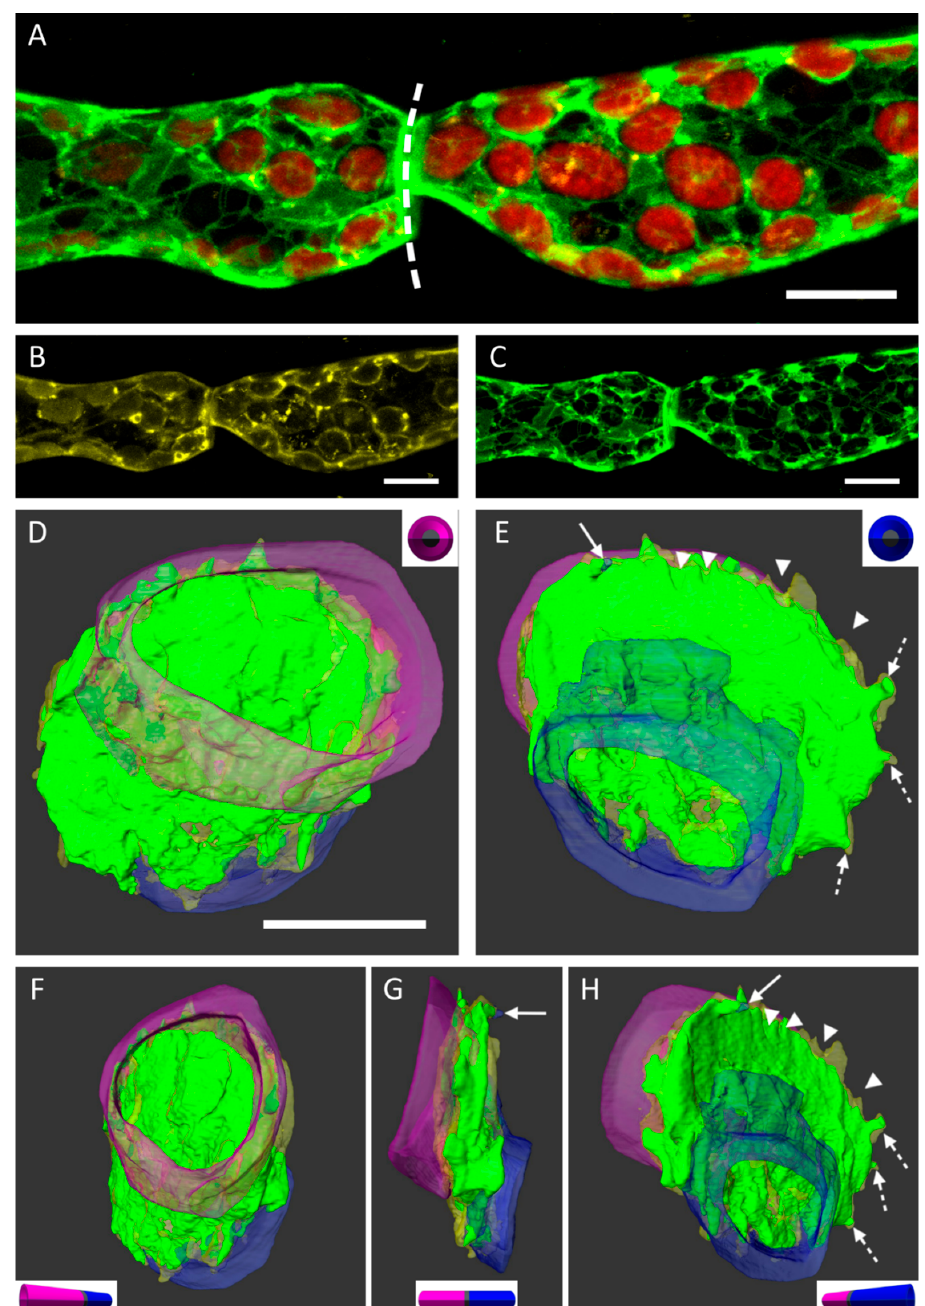
Figure 3. The cell wall of two plasmolyzed cells in partial detachment. ( A ) Maximum projection of a z-stack imaged by confocal laser scanning microscopy (CLSM) capturing the fluorescence of ER (green), chloroplasts (red) and PM (yellow). The dotted line indicates the approximated curvature of the cell wall between the protoplasts. ( B ) PM labeled with FM4-64. ( C ) Fluorescence of GFP-ER. ( D – H ) 3D reconstruction of z-stacks showing different perspectives. False-colored protoplasts in purple and blue correspond to the left and right side of the cell wall, respectively. Leftovers of the membrane and ER at the wall show a bigger connecting area of the blue protoplast and an indirect connection by another plasma strand (arrow) and via Hechtian reticula (dotted arrows). The ER and PM form little notches (arrowheads). Scale bars = 10 µ